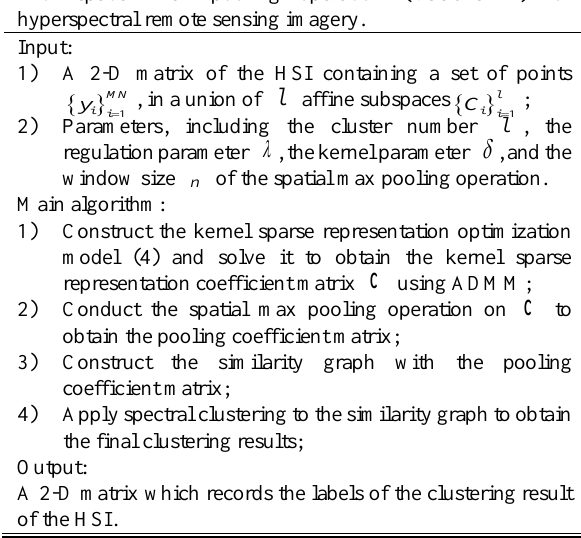
Algorithm 1 : The kernel sparse subspace clustering